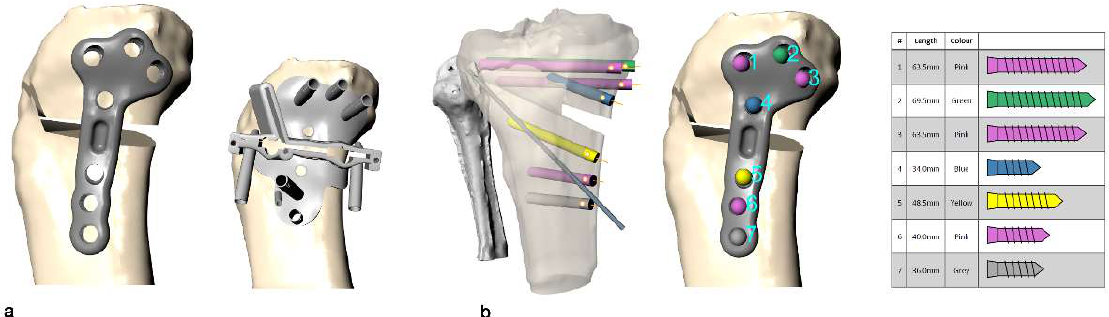
Figure 3. ( a ) The planning software generates the geometries of both the HTO stabilization plate, and the surgical guide contoured to the patient’s individual tibia surface geometry; ( b ) the planning software also records all screw lengths required.